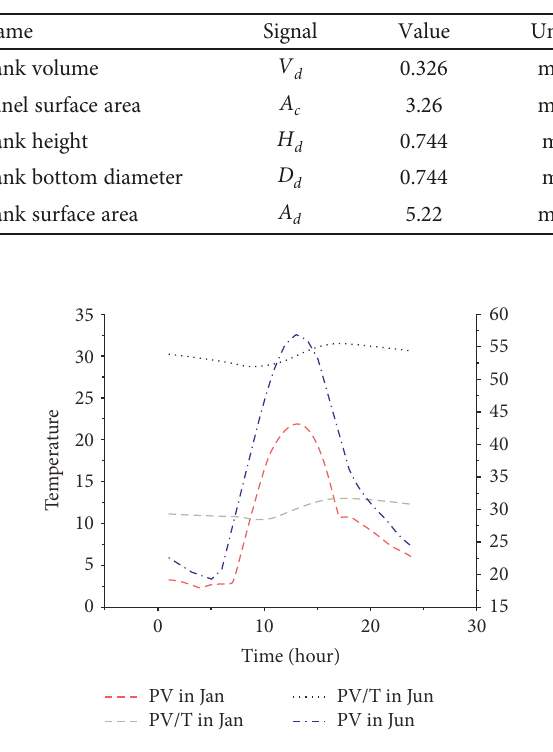
Figure 9: Panel temperature comparison between the PV and PV/T systems.